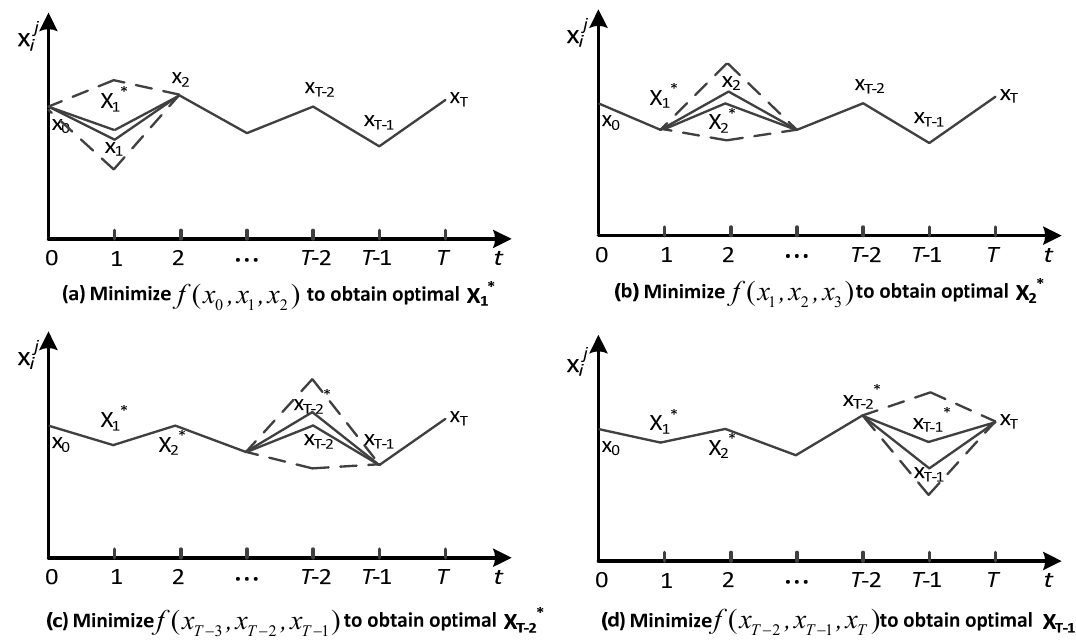
Figure 2. Optimization process of progressive optimality algorithm (POA).